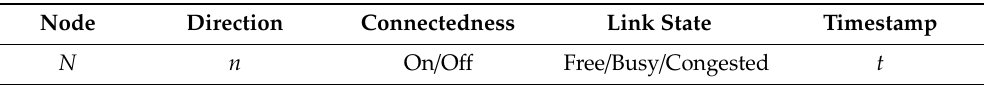
Algorithm 1 Dynamic Two ‐ Hops State Aware Updating